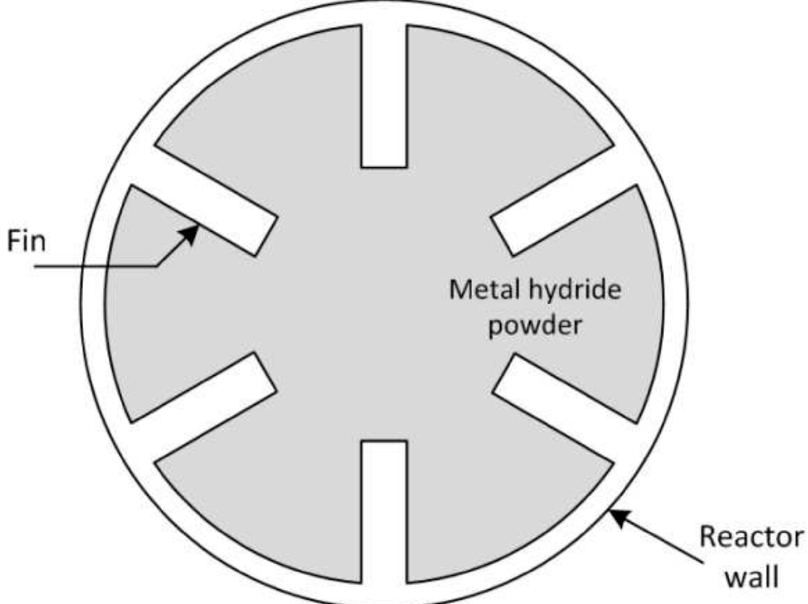
Figure 5. Cross-section of six-fin reactor.